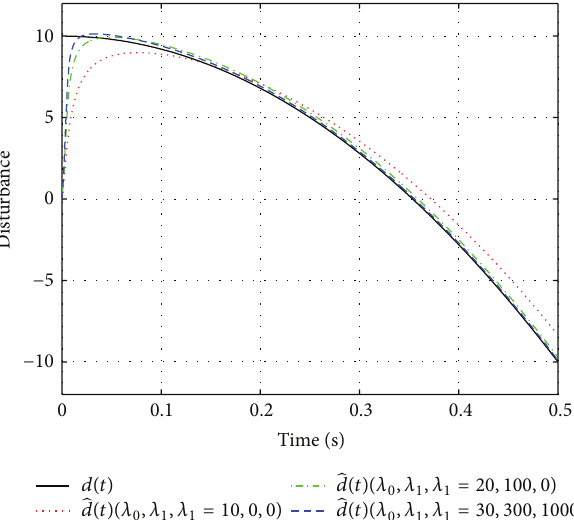
Figure 5: Results of Example 1 with different 𝑇 0 .